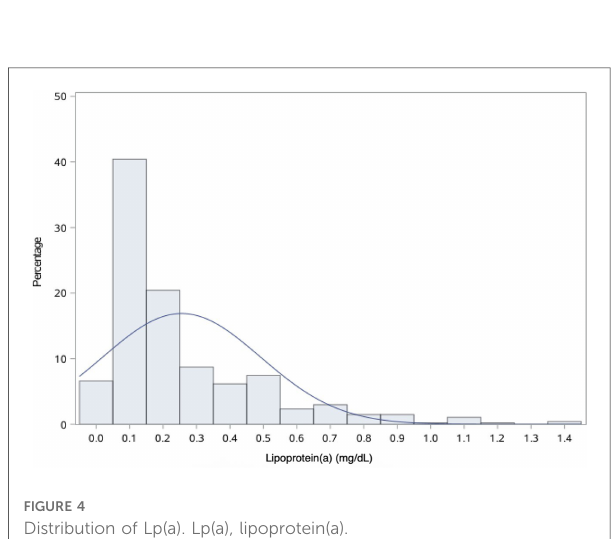
FIGURE 4 Distribution of Lp(a). Lp(a),